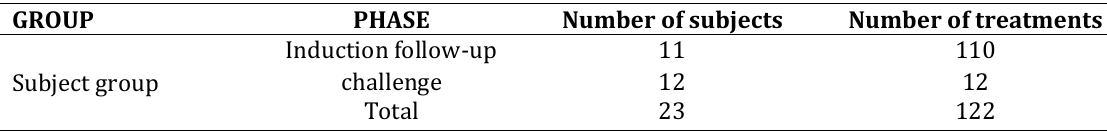
Table VII. Number of subject and treatment in each subject group GROUP